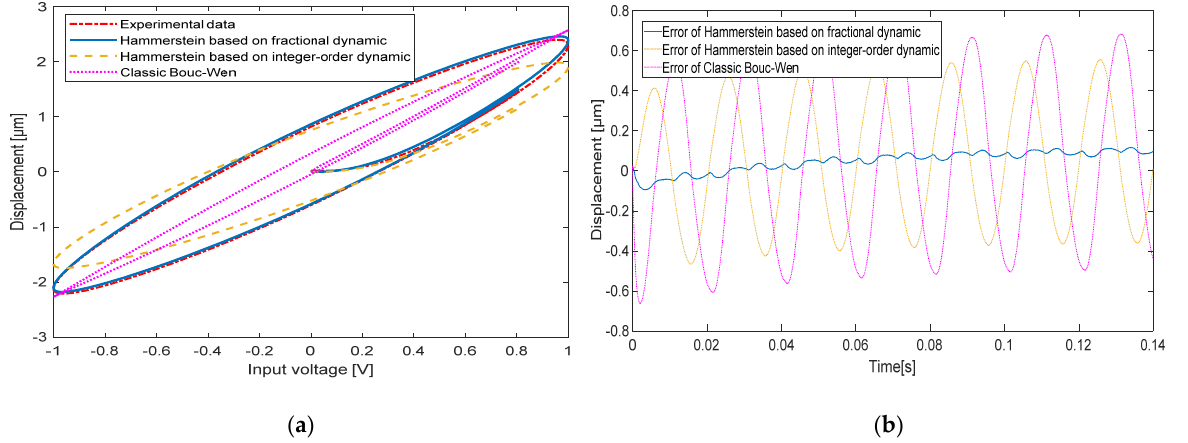
Figure 10. The comparison between experimental data and the Hammerstein model at 50 Hz: ( a ) Hysteresis loop; ( b ) Time curve.